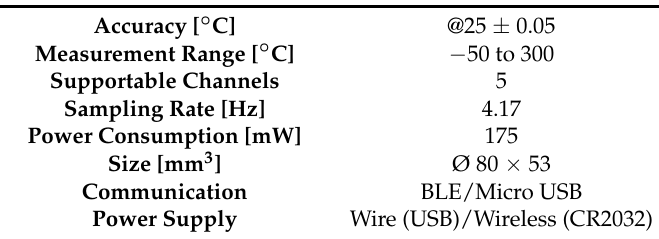
Table 2. Specification of TSWTM.